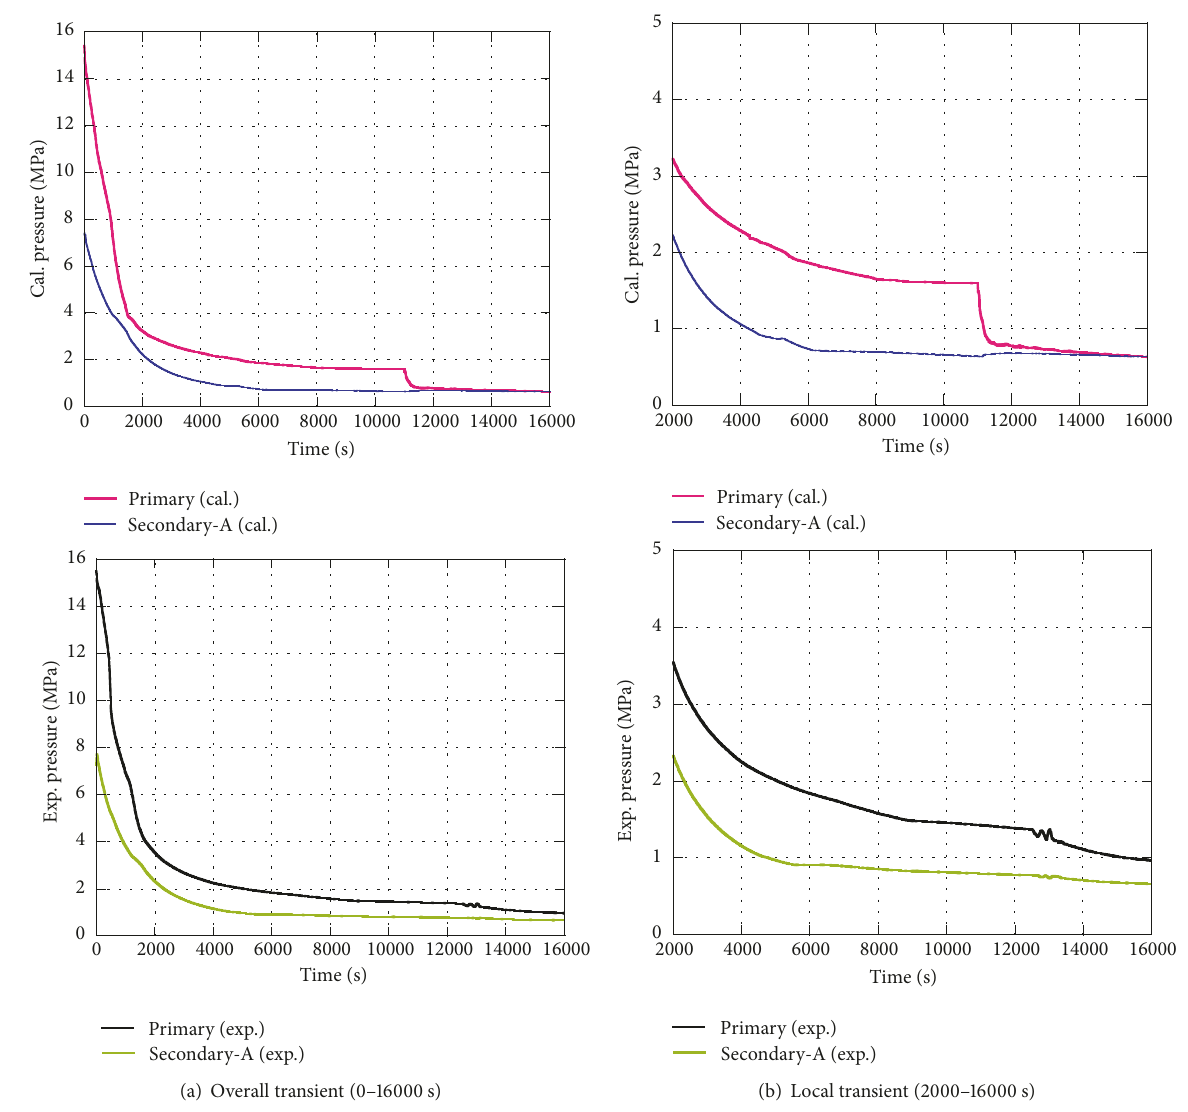
Figure 24: TR-LF-16 test and RELAP5 results for primary and SG secondary-side pressures in loop